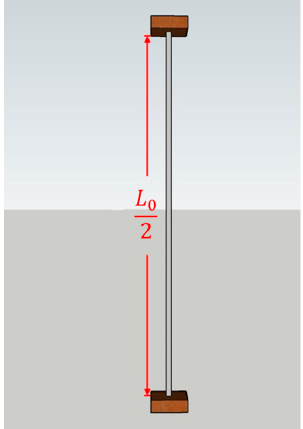
Figure 1. Unstrained wire length.